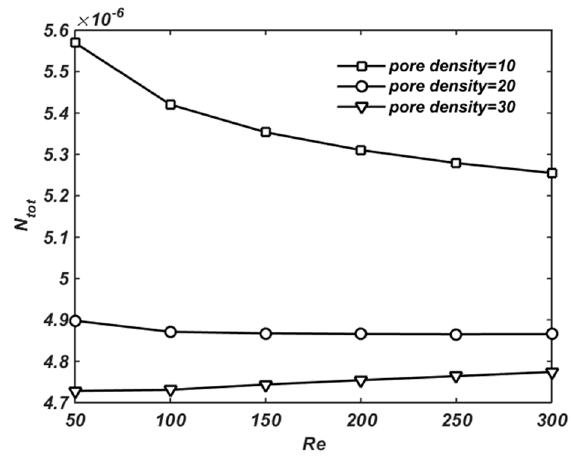
= Figure 9. N(cid:3368) (cid:3047)(cid:3042)(cid:3047) as a function of the Reynolds number (Re) in different ω . Figure 9. N tot as a function of the Reynolds number (Re) in di ff erent